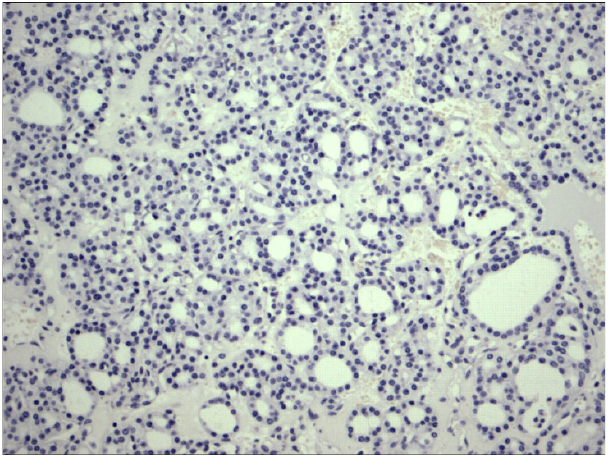
Follicular adenoma CK19 Figure 23